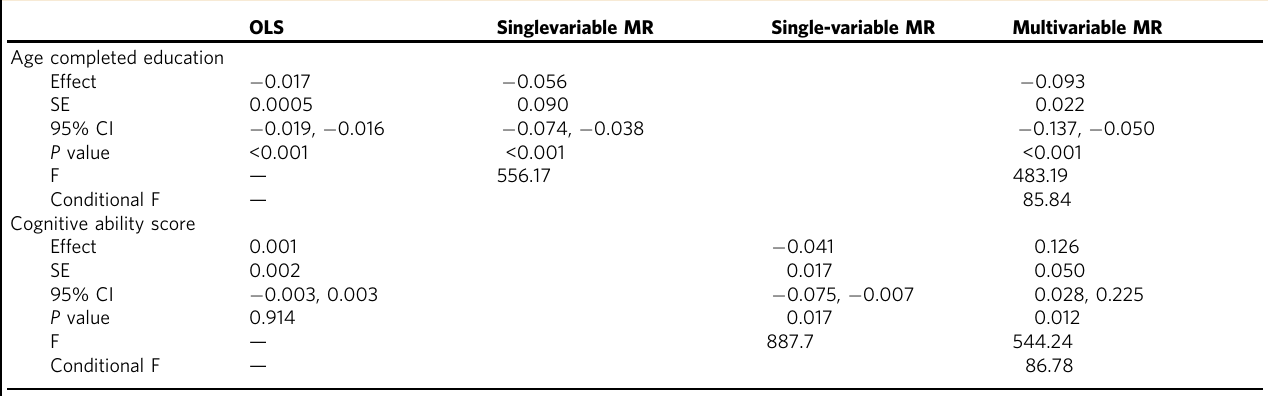
Table 2 The effect of education and general cognitive ability on smoking initiation